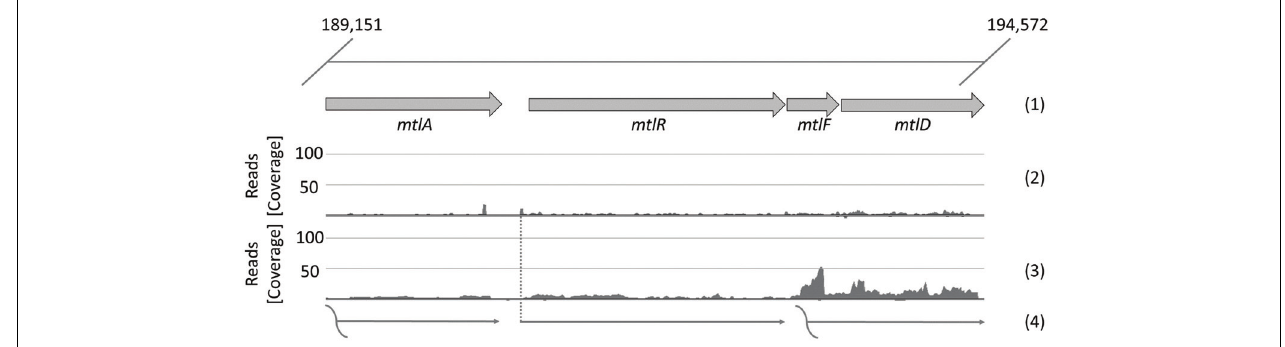
FIGURE 4 | Transcriptional organization of mannitol utilization pathway genes of B. methanolicus MGA3. The first line (1) represents the genomic organization of the genes in the cluster, the next one (2) the mapped reads of 5 (cid:48) -ends of primary transcripts, the third (3) depicts the mapped reads of whole primary transcripts and the last (4): the putative corresponding transcripts. The level of transcription is visualized with ReadXplorer (Hilker et al., 2014) and given as absolute reads (coverage) at the corresponding genomic positions. Data are based on the RNA-seq analysis of Irla et al. (2015).